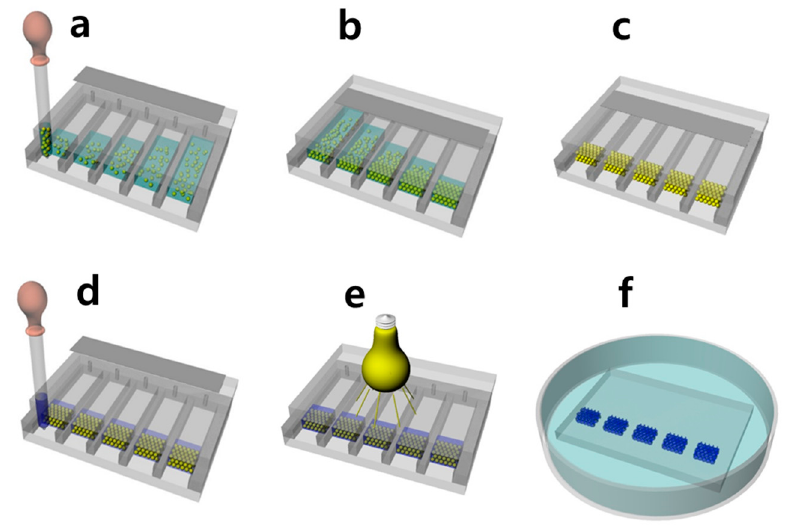
Figure 1. Schematic description for the fabrication procedure of the thermochromic photonic gel: ( a ) Infiltrating the aqueous dispersion of the PS in the five channels of the Directed Enhanced water Evaporation for Colloidal Assembly (DEECA) cell from the front slits with open pin-holes at the other ends; ( b ) Taping the pin-holes, and subsequently drying the water in order to induce colloidal crystallization at the fronts; ( c ) Annealing the dried PS opal templates; ( d ) Filling the precursor mixtures with different N -isopropylacrylamide (NIPAAM)/ 4-Acryloyl morpholine (ACMO) contents within the interstitial volume of the five opal templates; ( e ) UV lighte exposure and photopolymerization of the mixed monomers; ( f ) Etching away the PS templates in order to complete the fabrication of the five thermochromic photonic gels with controlled NIPAAM/ACMO contents.